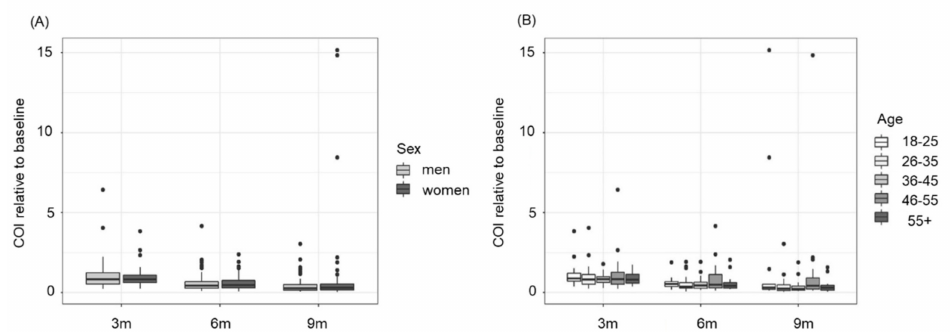
Figure 4. Decline in SARS-CoV-2 anti-N total antibody levels is not significantly dependent on sex or age. ( A ) No significant difference could be observed between women ( n = 56) and men ( n = 64) regarding antibody dynamics over time (3, 6 and 9 months (m) post initial blood donation). ( B ) Analysis according to different age groups (age 18–25: n = 15; age 26–35: n = 27; age 36–45: n = 23; age 46–55: n = 33; age 56+: n = 22) revealed no significant differences over time. Data shown are cut-off indices (COI) of SARS-CoV-2 anti-N total antibodies relative to the baseline signal (=COI value of the initial blood